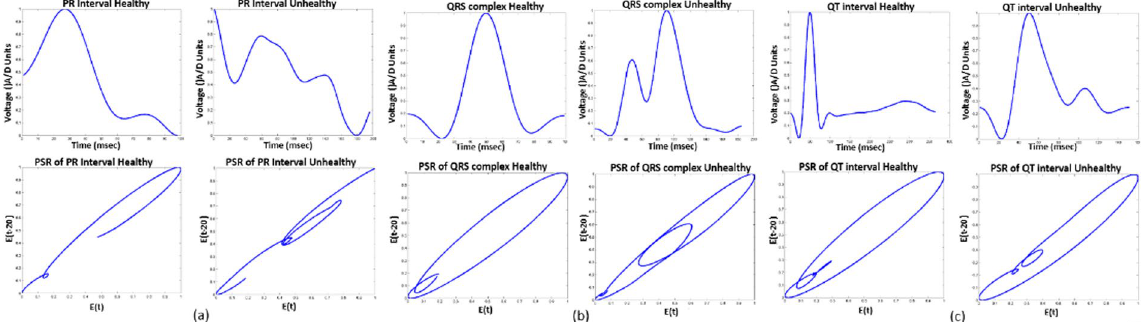
Figure 13. PSR images of PR interval, QRS complex and QT interval with healthy and unhealthy cases.